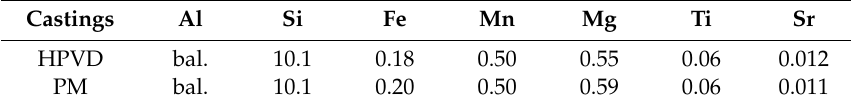
Table 1. Chemical composition (wt%) of high pressure vacuum die and permanent mold castings. Castings Al Si Fe Mn Mg Ti Sr HPVD bal. 10.1 0.18 0.50 0.55 0.06 0.012 PM bal. 10.1 0.20 0.50 0.59 0.06